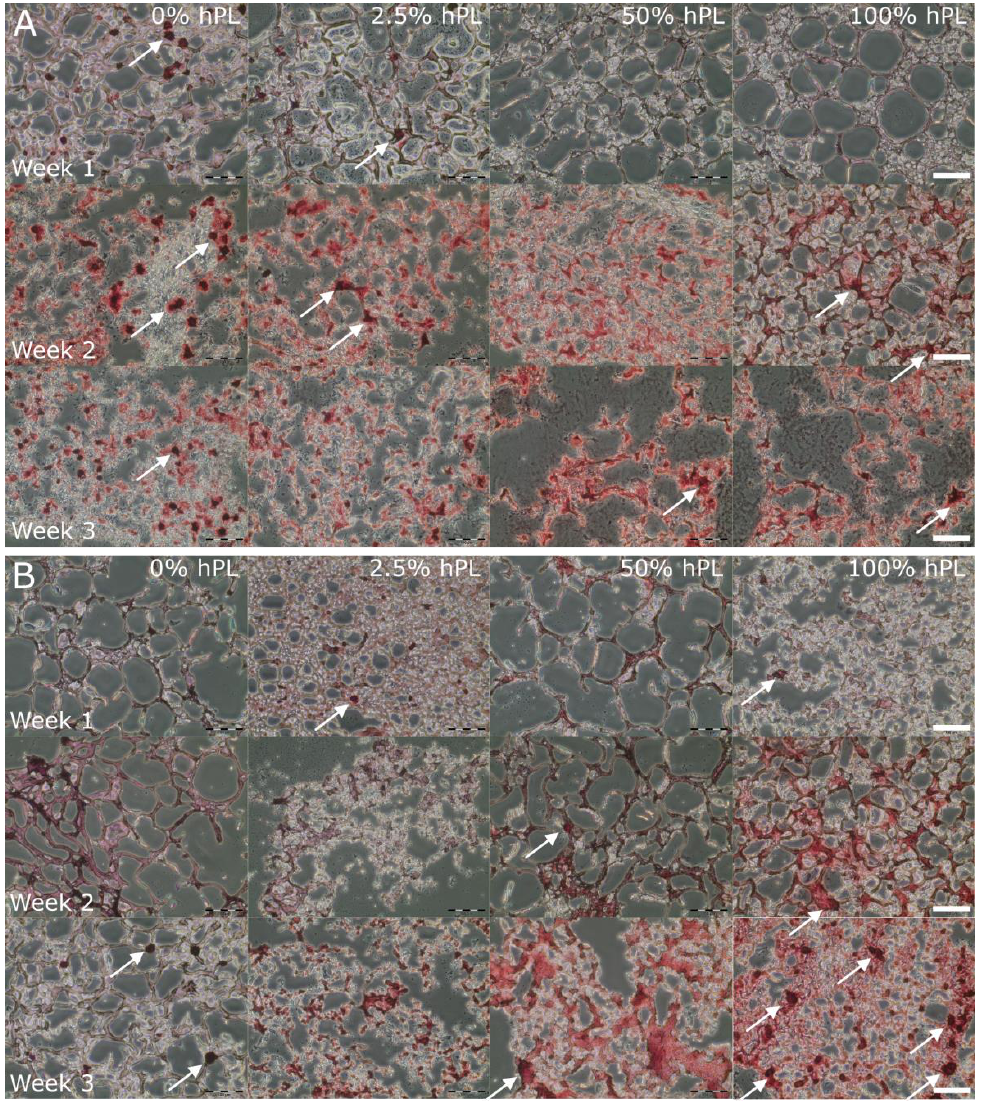
Figure 3. Osteogenic differentiation of AD-MSCs encapsulated in 5% (w/v) GelMA with ( A ) 50% DoF and ( B ) 70% DoF, formulated with 0, 2.5, 50, and 100% hPL. The GelMA-hydrogels were cryosectioned (12 µm) and stained with Alizarin Red 7, 14, and 21 days after induction of the osteogenic differentiation; 10× objective, scale bar 100 µm.